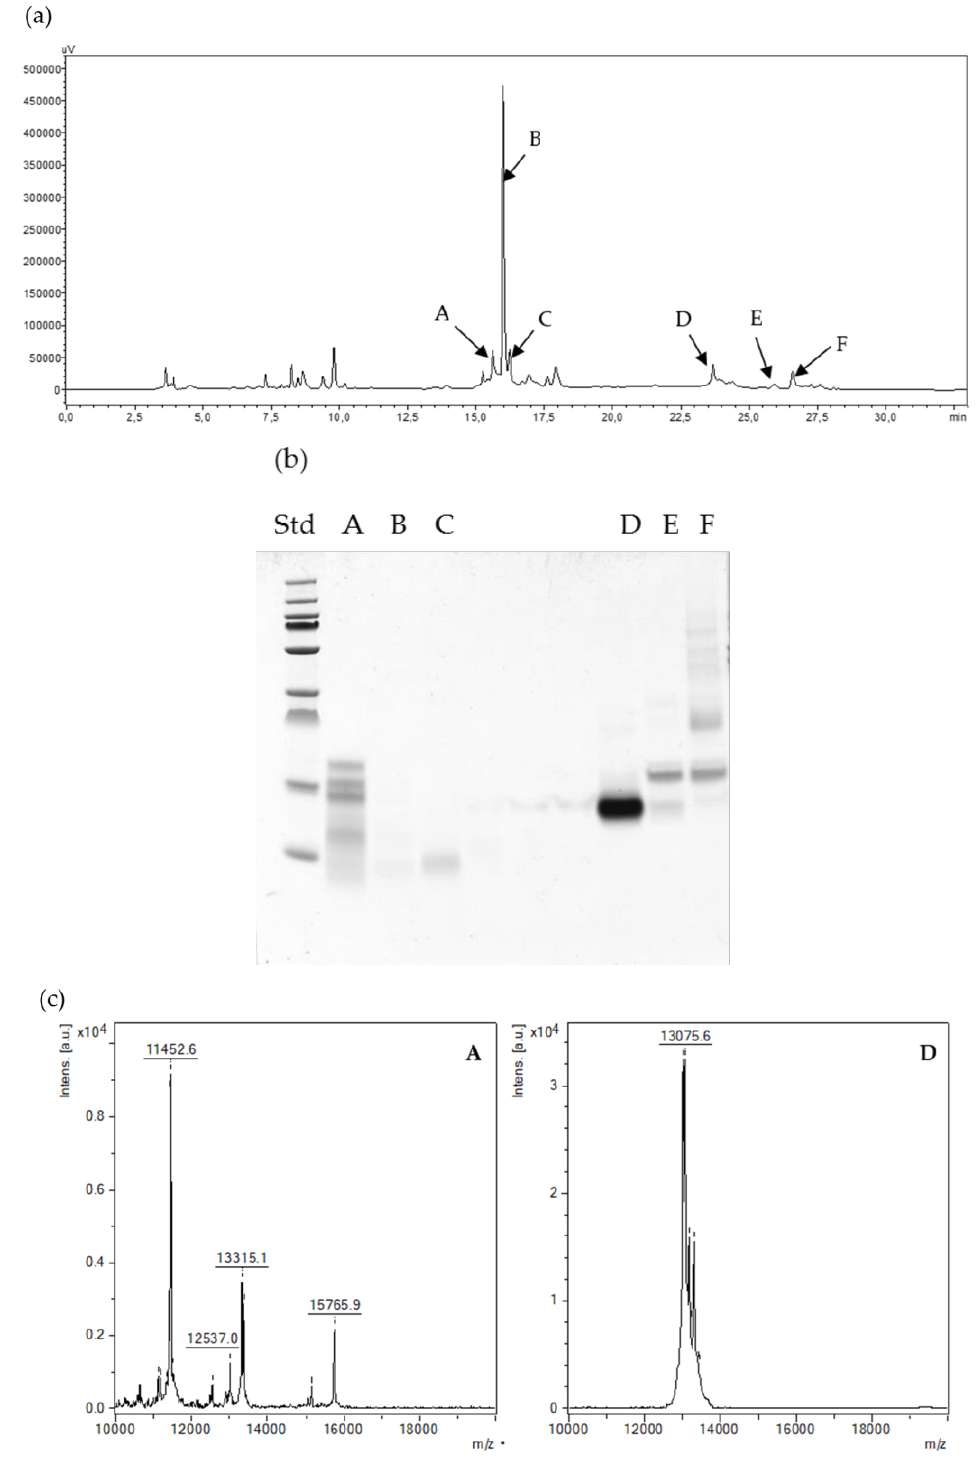
Figure 3. HPLC fractionation ( a ), SDS-PAGE ( b ) and MALDI TOF MS ( c ) of extracted ATIs from Ponticus .